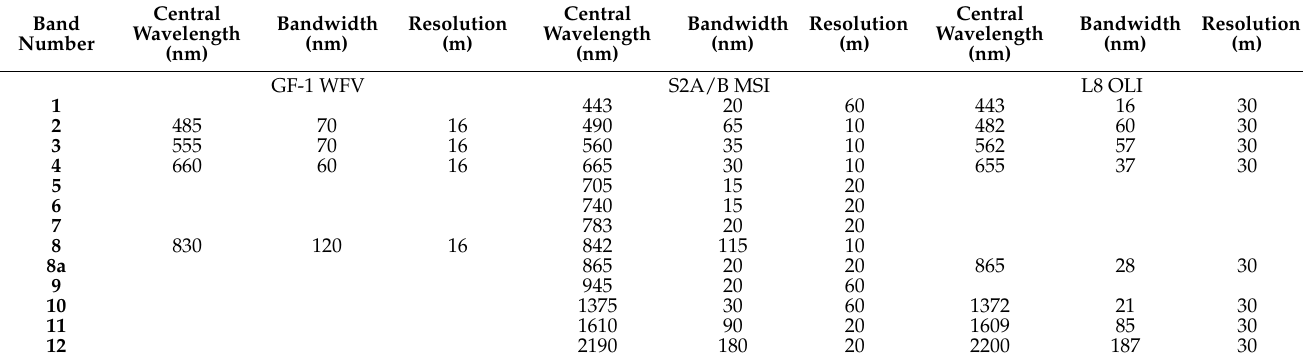
Table 1. The band specification and spatial resolution of GF-1, S2 and